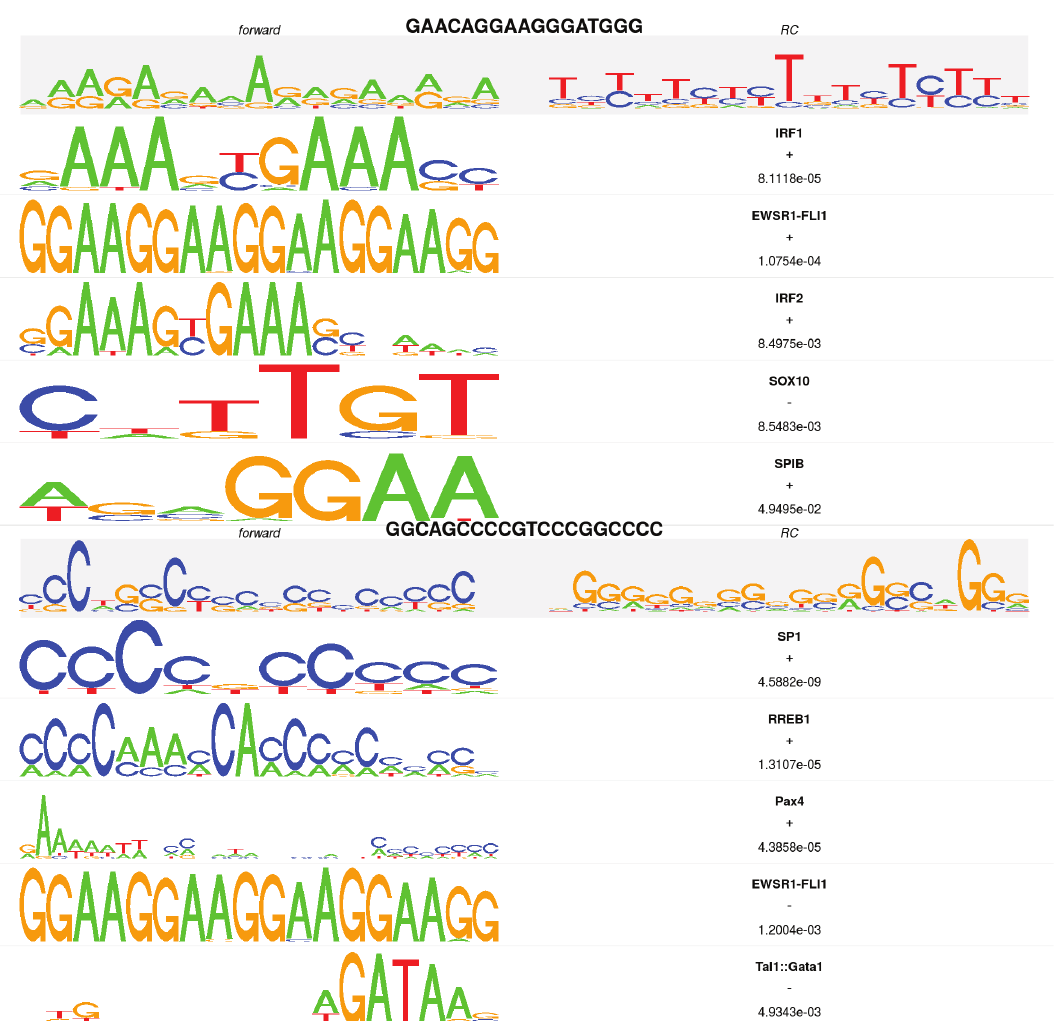
Figure 12. Identified transcription factors: the sequence logo, the name of the motif match and the p-value of the alignment.